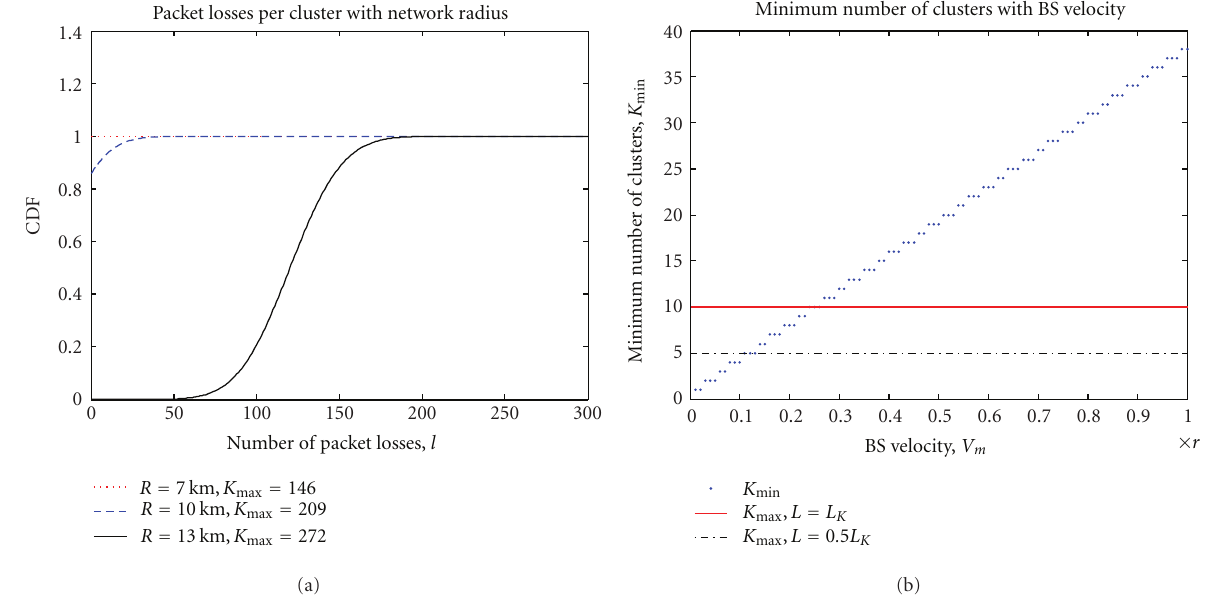
Figure 6: (a) The CDF of packet losses, (4) at relaxed delay requirement. The approximate upper bound of network radius R ≤ 4 . 64 r from (9). (b) The approximate K min and K max , from (2) and (5), respectively, with BS velocity when R = 5 r